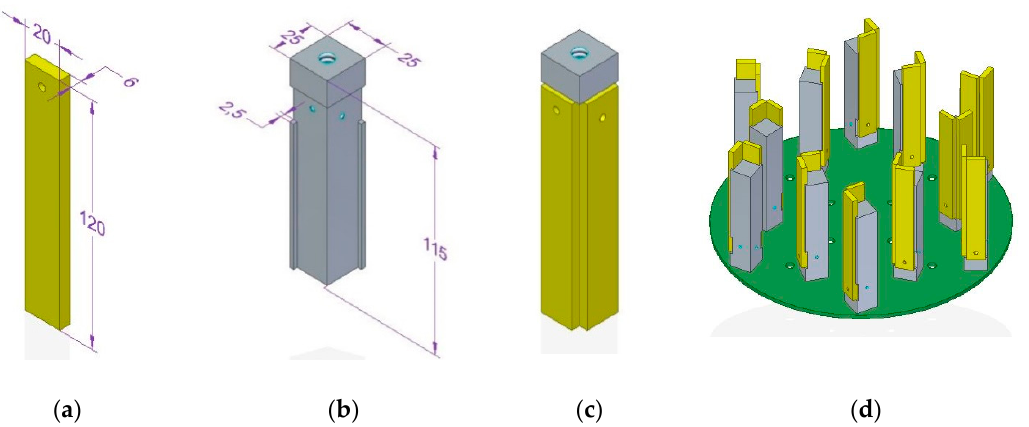
Figure 4. Assembly line of the specimen system: polymer sample, steel holder column, samples placed on the column, and finally, the holder unit in an upside-down position: ( a ) test specimen; ( b ) specimen holder; ( c ) two specimen placed on holder; ( d ) layout on the disc, upside down drawing.